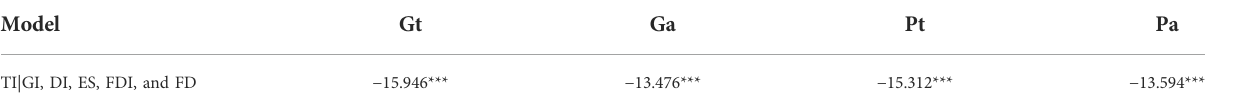
TABLE 4 Results of panel cointegration test-error correction term.